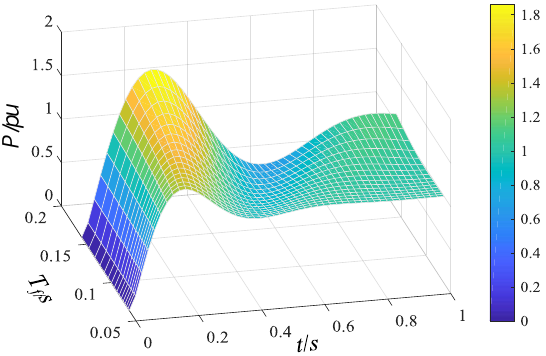
Figure 5. Step response of Gr ( s ) with T f varies.